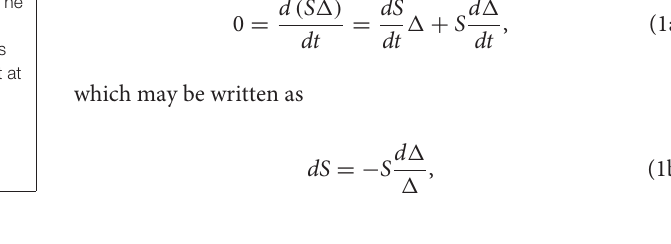
TABLE 1 | List of major tropical cyclones passing over or near to the KEO buoy during the study period. Tropical cyclones Lowest Maximum wind speed (m/s) Arrival time at KEO Accumulated precipitation pressure (hPa)